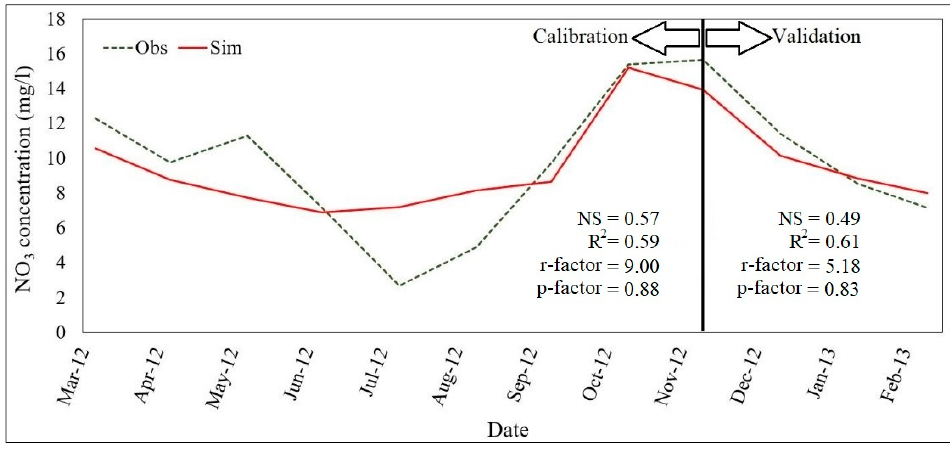
Figure 8. Calibration and validation of monthly nitrate concentration in Dezful station (2012–2013).